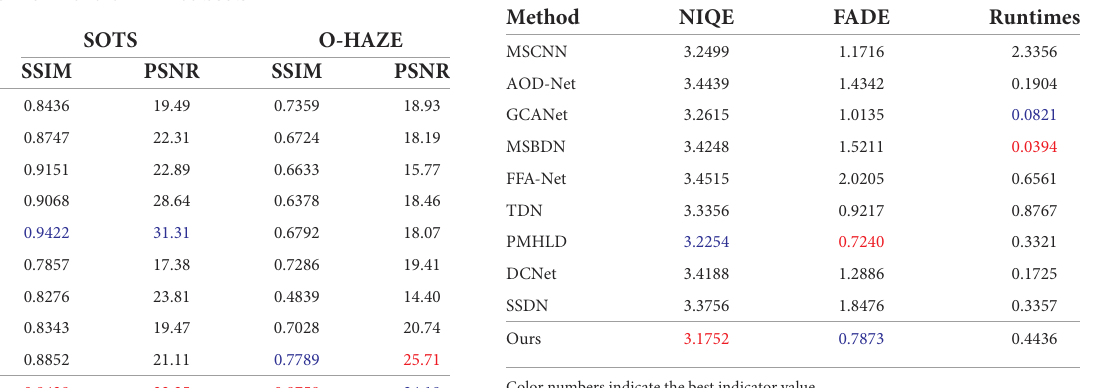
TABLE 2 Quantitative and efficiency comparison in RTTS